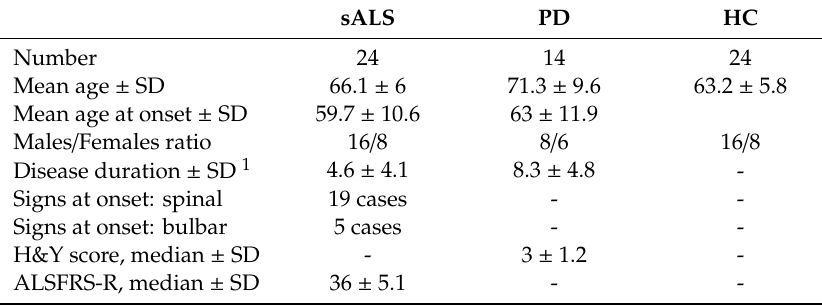
Table 1. Demographic and clinical characteristics of patients with amyotrophic lateral sclerosis (ALS) and with Parkinson’s disease (PD) and healthy controls (HCs). sALS PD